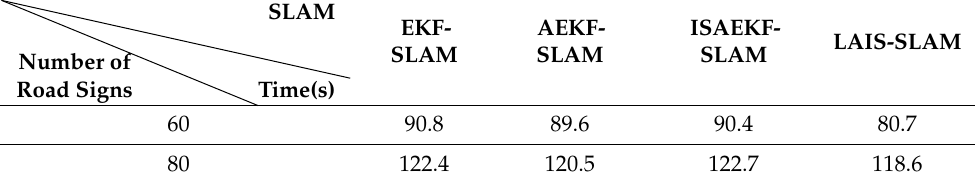
Table 4. Time for complete map construction of each algorithm.